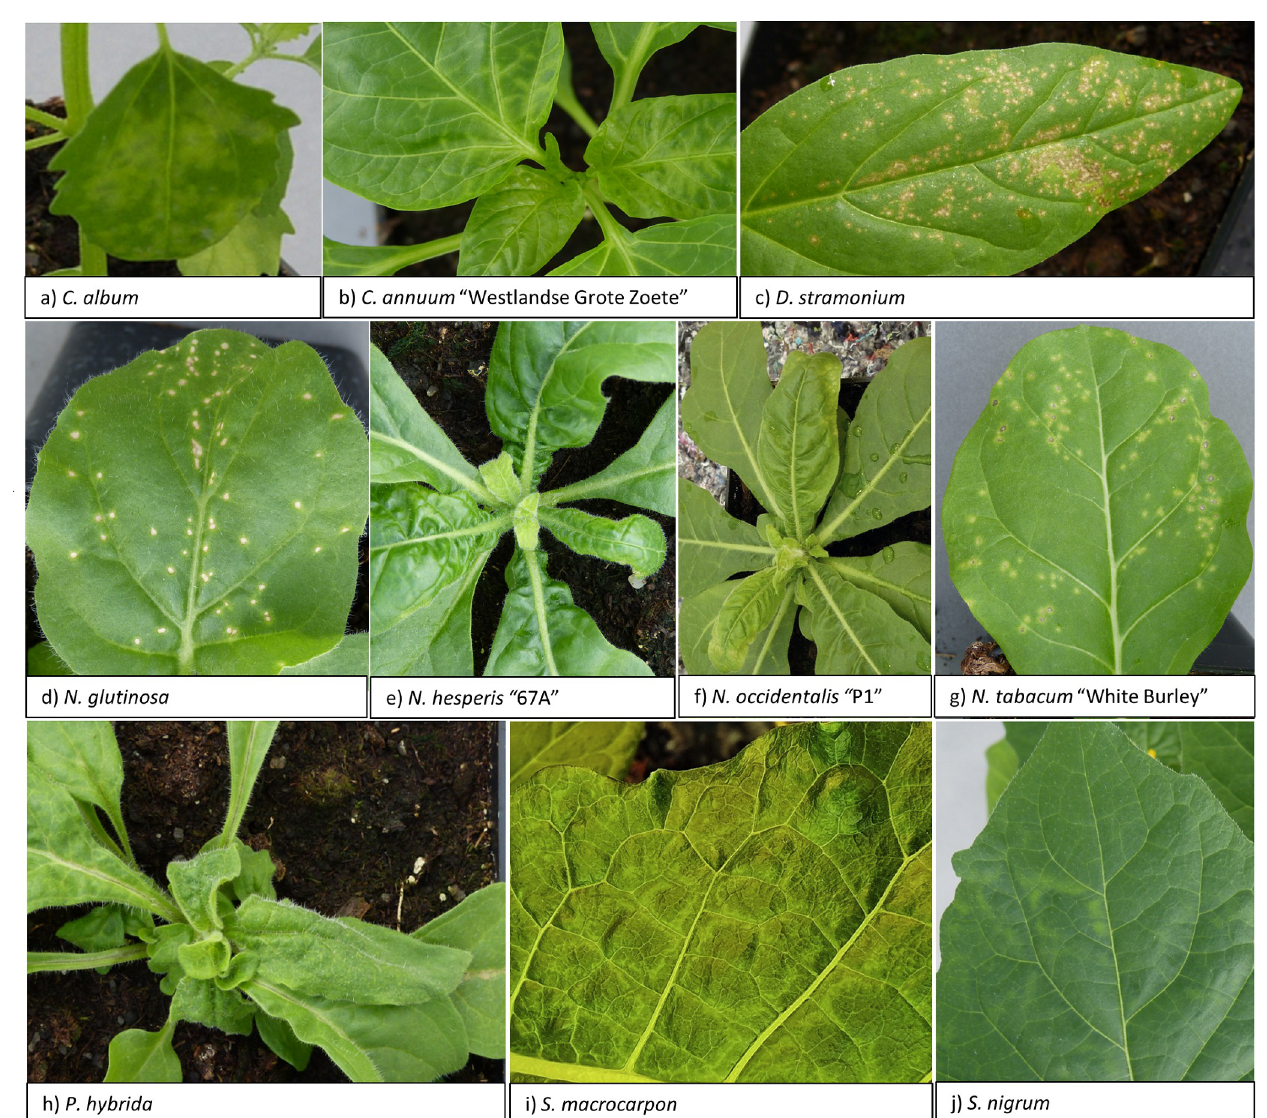
Fig 3. Symptoms on test plants upon inoculation with the novel tobamovirus. a) Chenopodium album : local chlorotic lesions, b) Capsicum annuum “Westlandse Grote Zoete”: systemic chlorosis, c) Datura stramonium : local necrotic lesions, d) Nicotiona glutinosa : local necrotic lesions, e) Nicotiana hesperis “67A”: systemic chlorosis, growth inhibition, rugosity, f) Nicotiana occidentalis “P1”: systemic chlorosis, growth inhibition, leaf curling, rugosity, g) Nicotiana tabacum “White Burley”: local chlorotic lesions, h) Petunia hybrida : local necrotic lesions, systemic leaf curling, growth inhibition, rugosity, i) Solanum macrocarpon : systemic chlorotic vein banding, j) Solanum nigrum : systemic chlorotic lesions, rugosity.